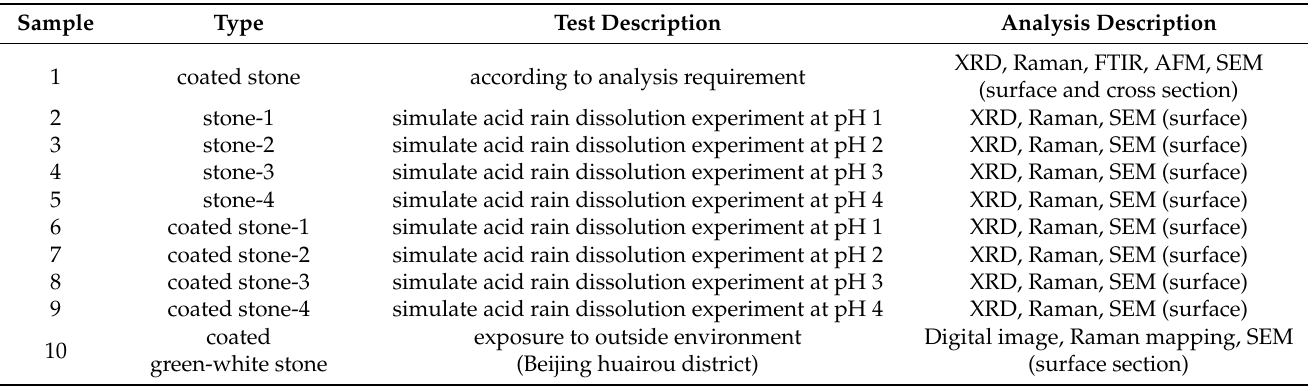
Table 1. Characteristics of the